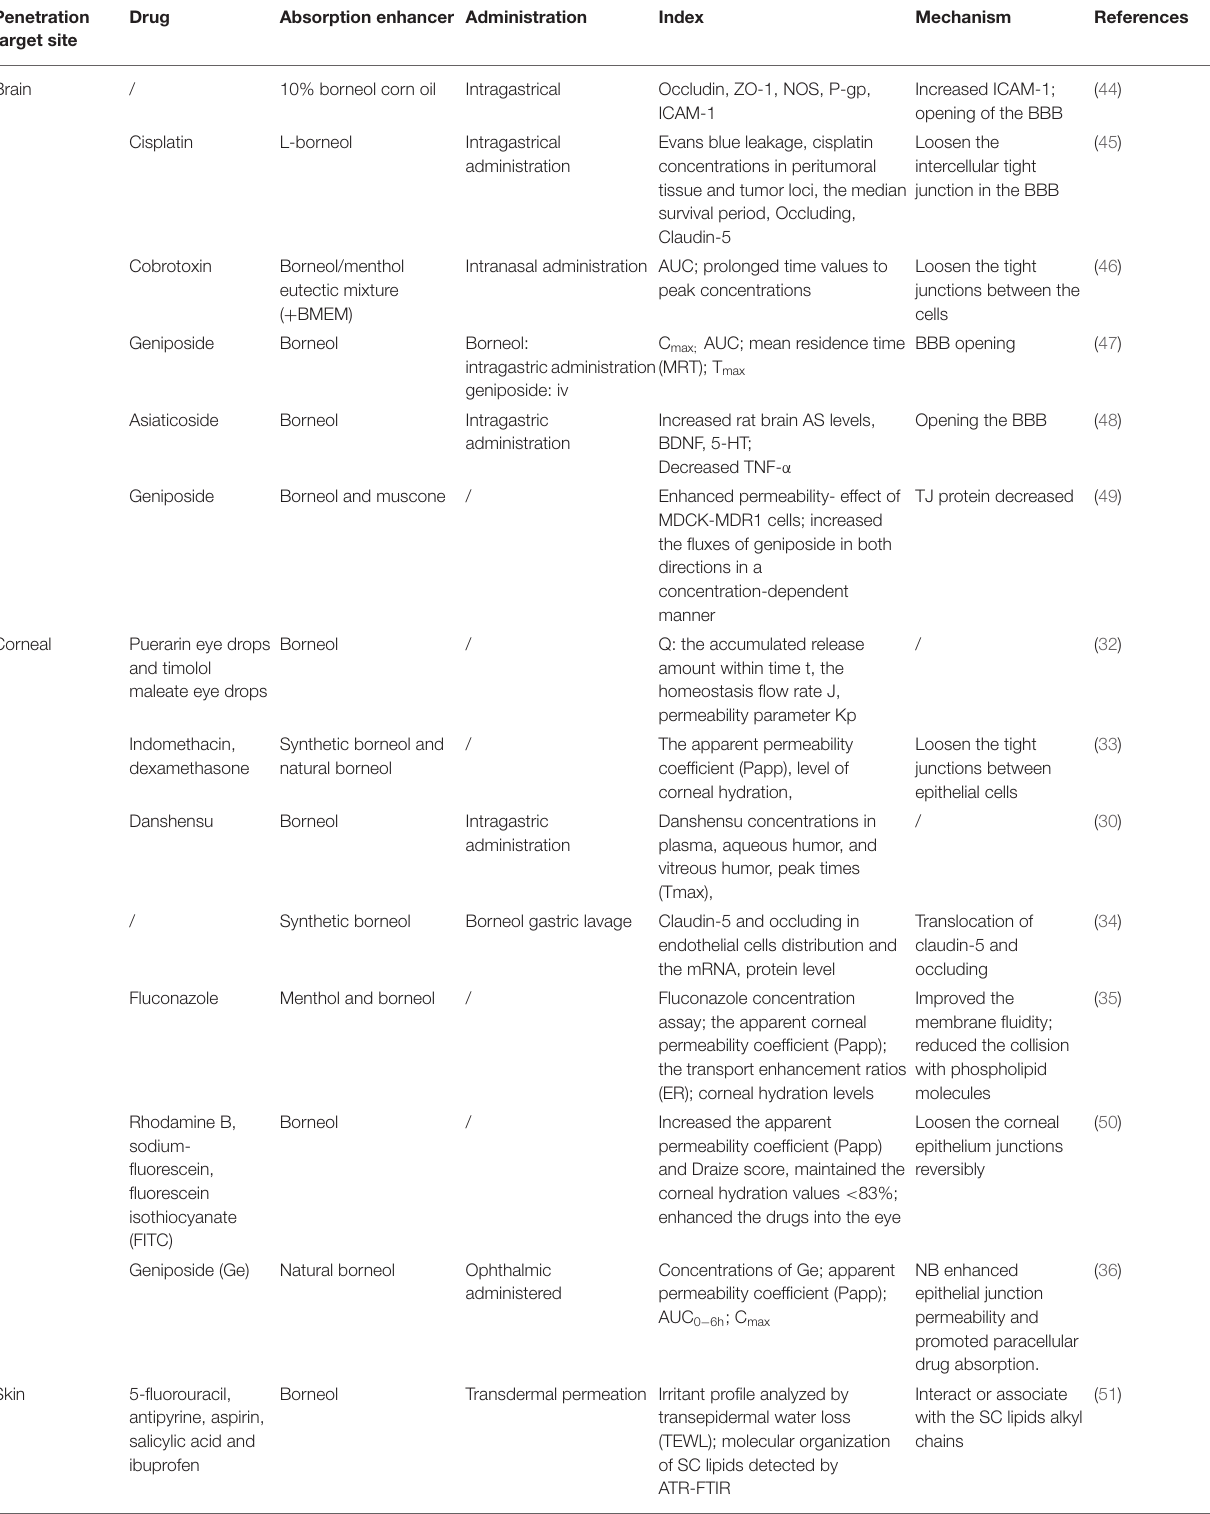
TABLE 1 | The penetration promoting effect of borneol in brain, corneal, nasal mucosa, skin, and gastrointestinal mucosa. Penetration target